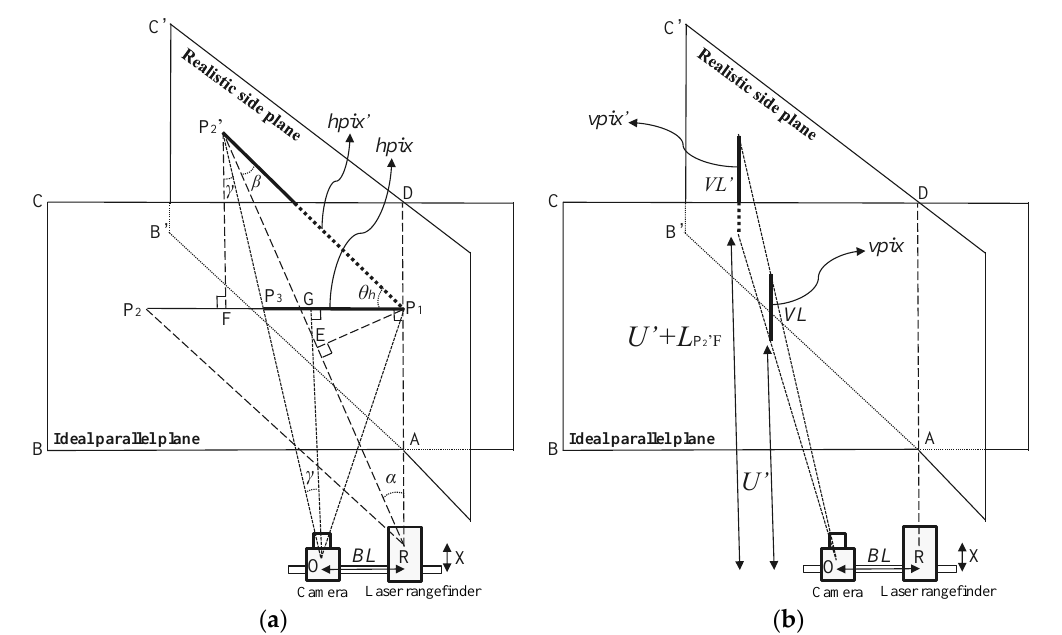
Figure 4. Decomposition of unparallel plane into horizontal and vertical orientation.